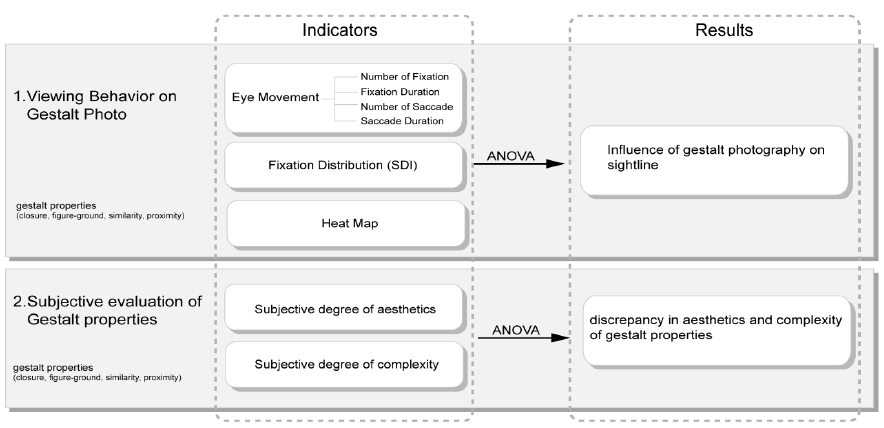
Figure 3. Research